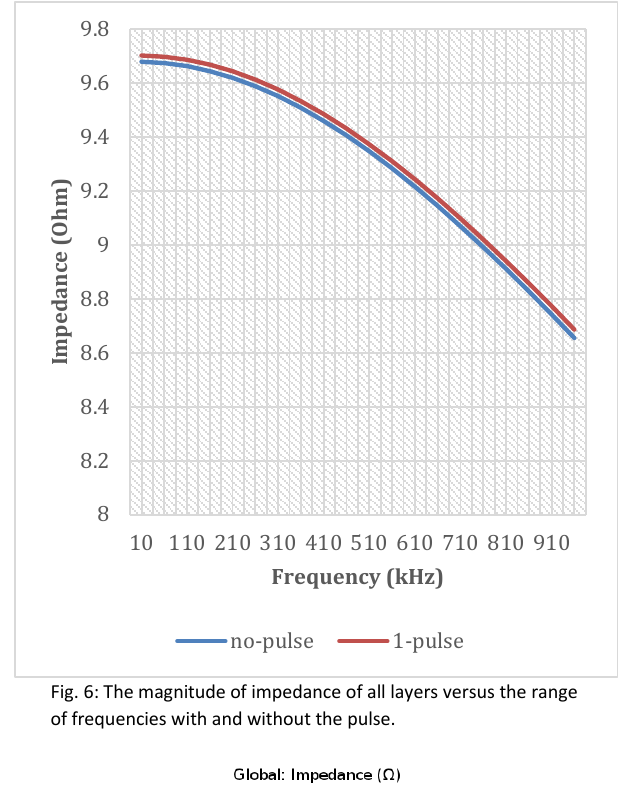
Fig. 5: The dynamic fluid properties of blood: A) the velocity, and B) the pressure .